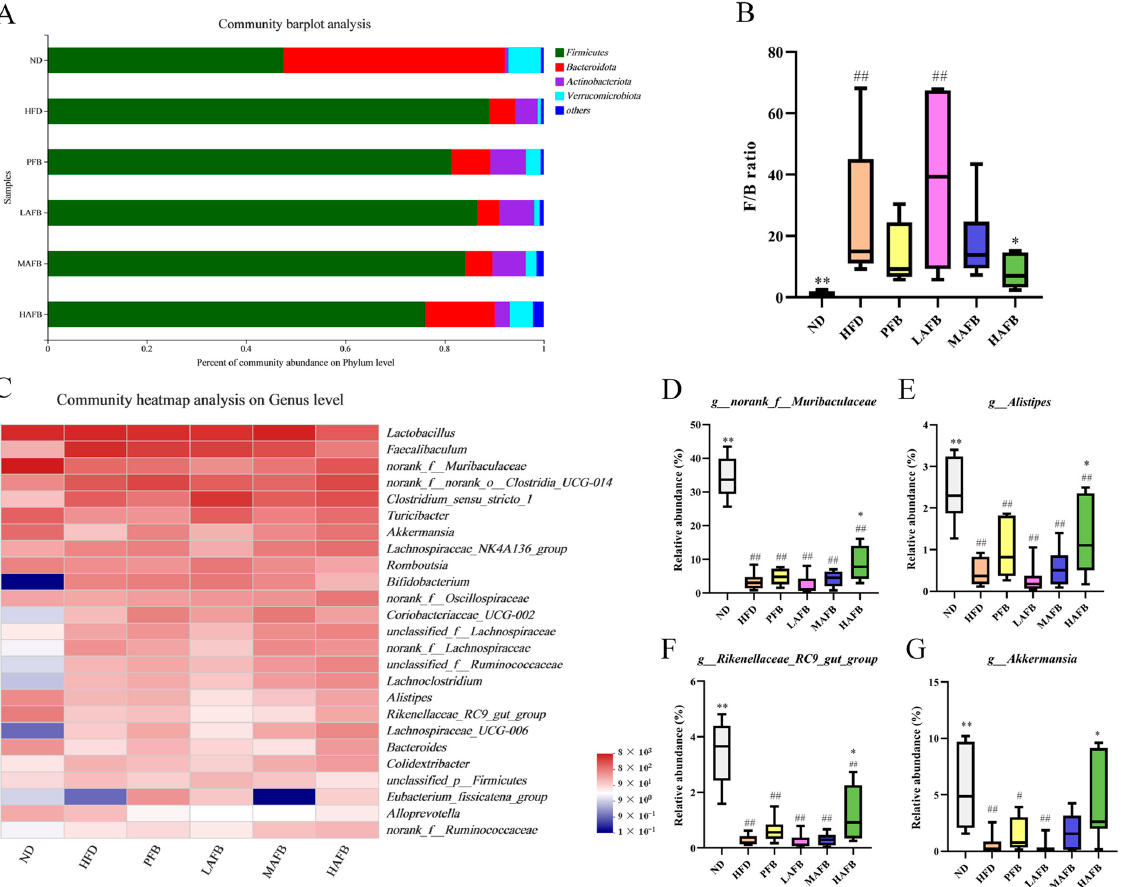
Figure 5. AFB restructured the mouse gut microbiota. ( A ) Relative abundance of gut microbiota at the phylum level. ( B ) F/B ratio. ( C ) Heatmap of the relative abundance of each group at the genus level. ( D – G ) The relative abundances of some genera were significantly changed due to the consumption of AFB. * p < 0.05, ** p < 0.01 versus the HFD group and # p < 0.05, ## p < 0.01 versus the ND group by one-way ANOVA. Table 2. Concentration of SCFA in the feces of each group of mice.